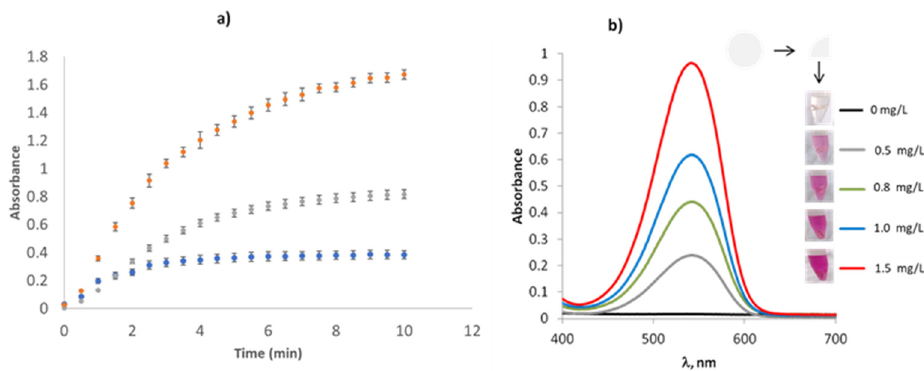
Figure 3. ( a ) Griess reaction time optimization employed PDMS sensing devices for different nitrite concentrations. ( b ) Vis spectra of different NO − 2 solutions employing Griess reagents entrapped in PDMS membranes.